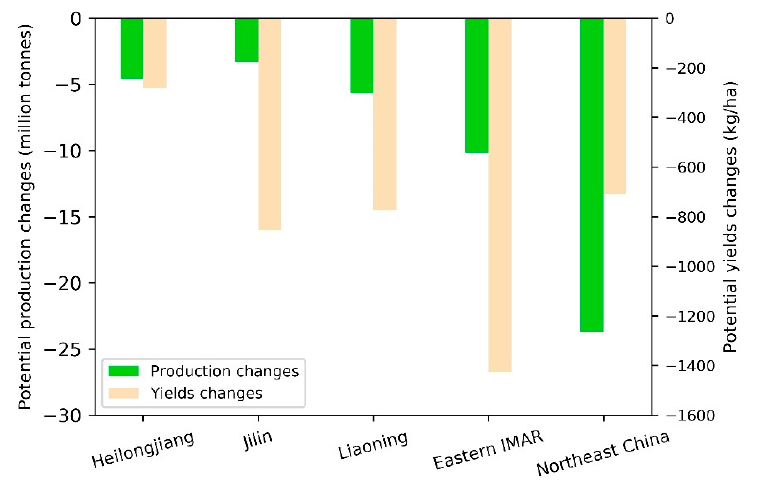
Figure 8. Maize potential production and yields changes during 2015–2050.